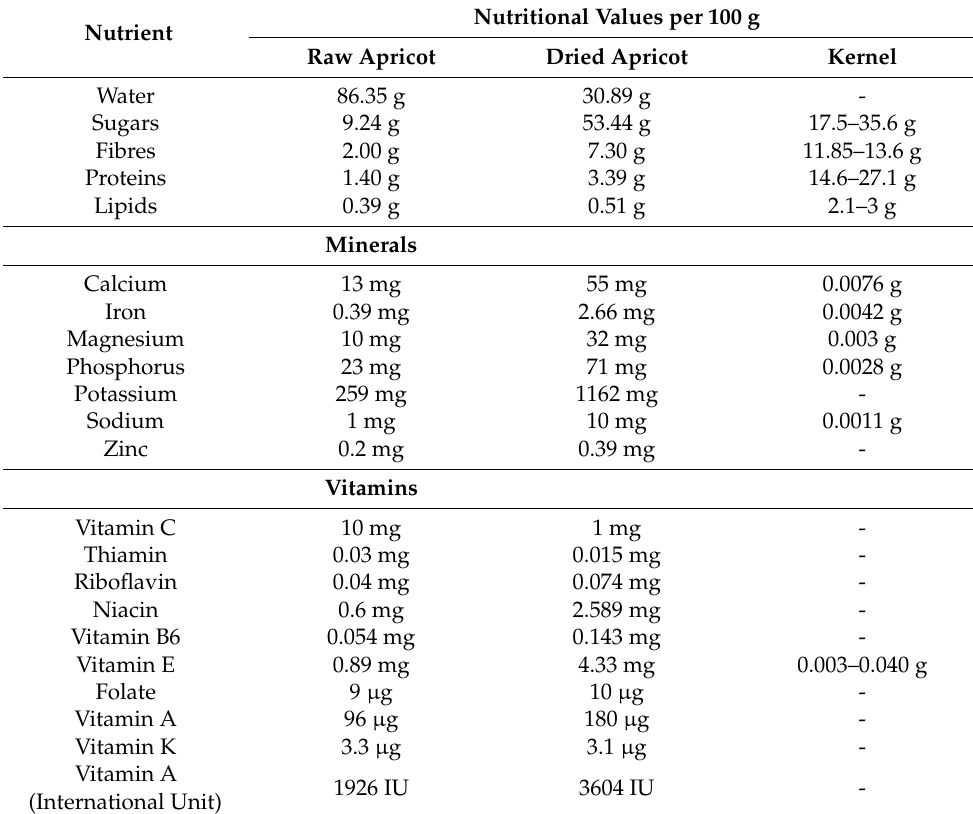
Table 1. Nutritional values of apricot (fresh and dried fruits)